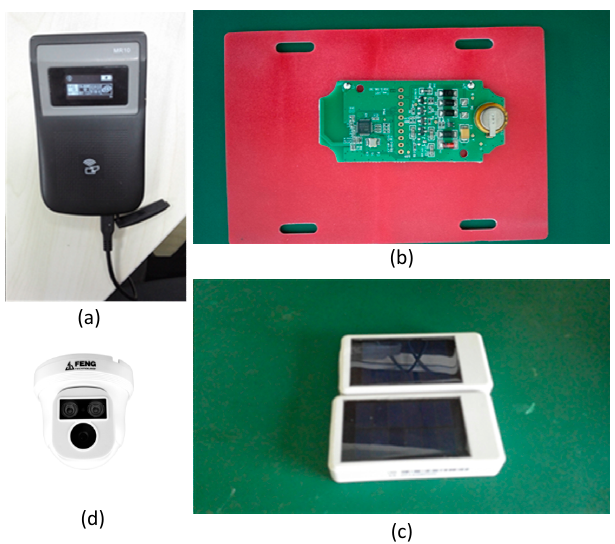
Figure 5. Context-aware hardware: ( a ) RFID reader; ( b ) Integrated circuit board containing RFID tag and ambient sensors; ( c ) The integrated circuit board is placed in a box to prevent potential damage from dust, water and other factors; ( d ) High-definition video cameras for real-time surveillance of cultural relics with infrared imaging and motion detection features. Table 1. Specifications of context-aware hardware.